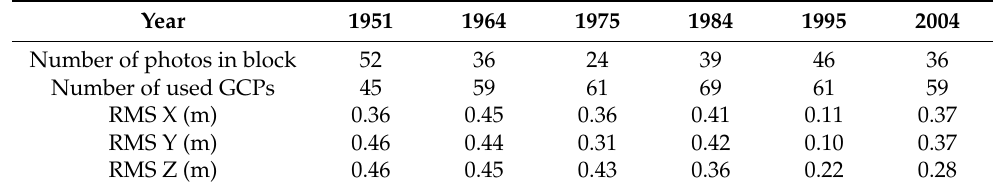
Table 2. Results of the aerotriangulation process for images for subsequent